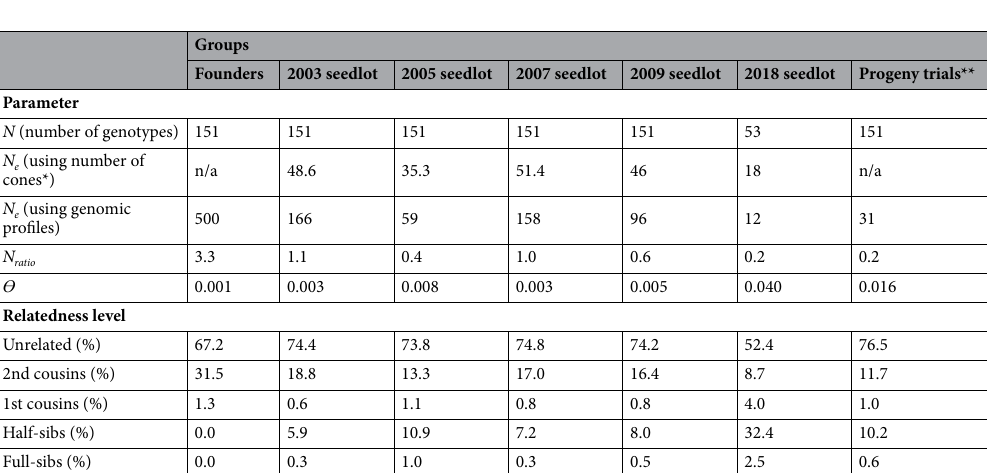
Figure 1. Genetic diversity parameters across groups (founders, seed orchard seedlots and progeny trials) and years in the G1 white spruce orchard, using tree genomic profiles with a set of 2000 SNPs. Bars indicate Shannon Index ( I ) + 1 standard error, and the green (dots), blue (triangles) and red (squares) lines indicate expected heterozygosity ( H e ), observed heterozygosity ( H o ) and the inbreeding coefficient ( F i ), respectively. A is the average number of alleles per SNP. The black dotted line denotes a zero inbreeding coefficient.